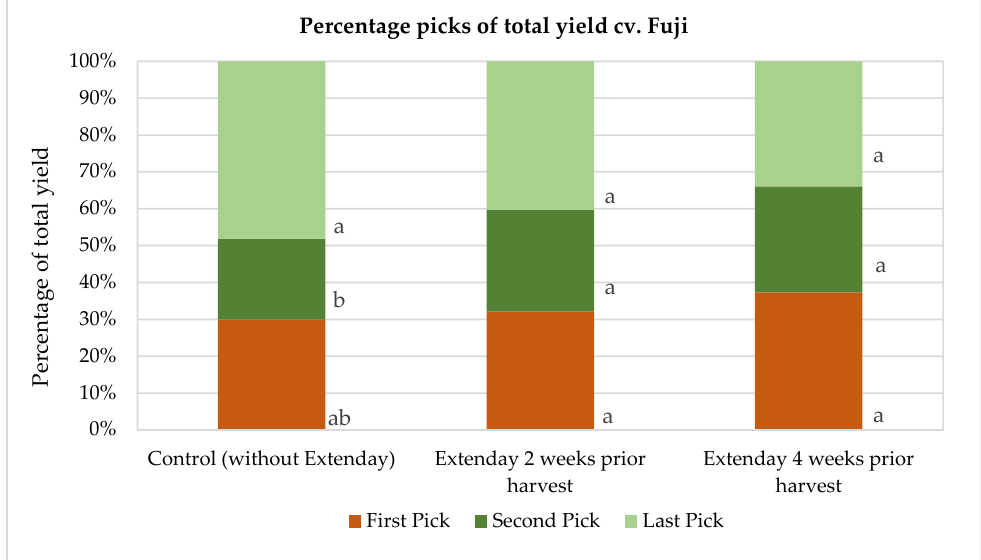
Figure 3. Summation of yield in each pick of cv. Fuji as dependent on the timing of reflective mulch in Motueka, New Zealand, (41° S). (Picks with different letter for the same treatment are statistically different ( p < 0.05) (n = 60 fruit per treatment per position)).